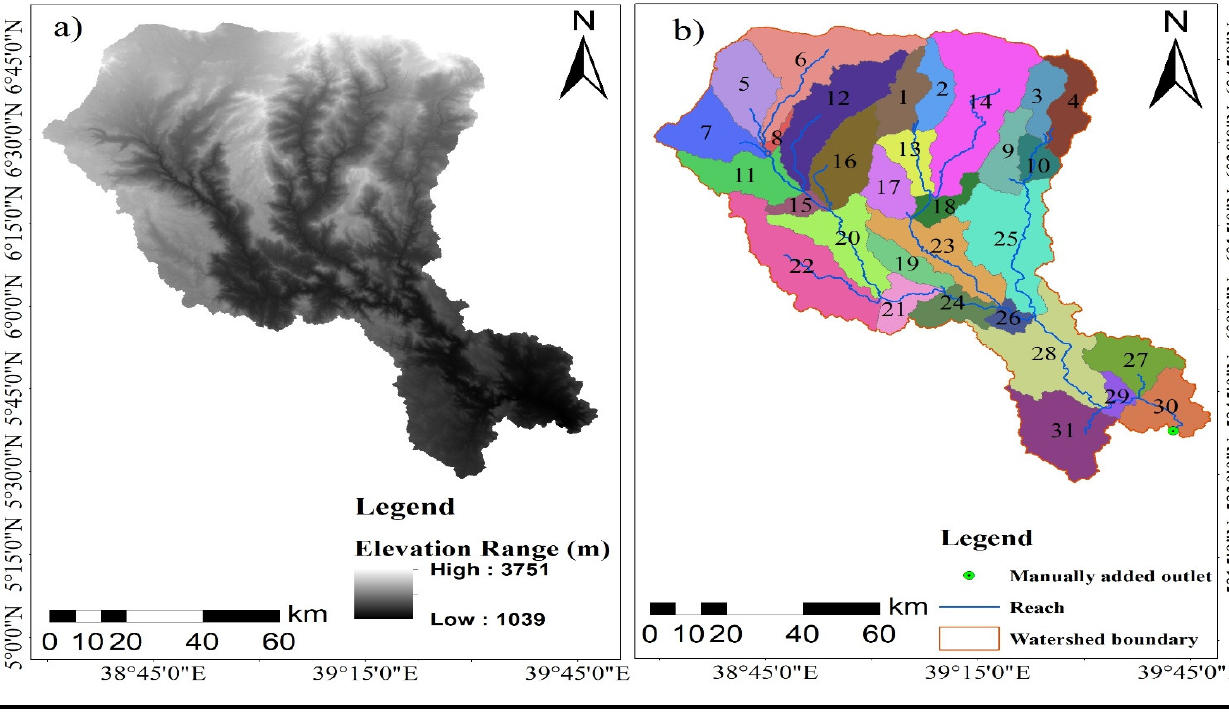
Figure 3. ( a ) The digital elevation model; ( b ) the delineated watershed map of the area and its sub- basins.